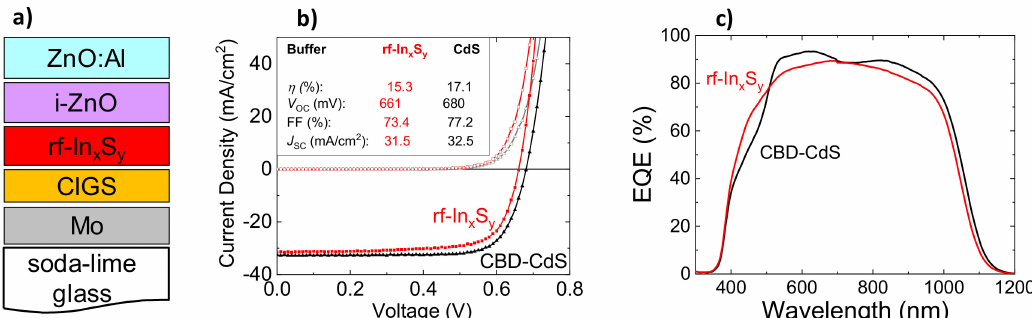
Figure 1. ( a ) Scheme of Cu(In,Ga)Se 2 (CIGS) thin-film solar cell with rf-sputtered In x S y bu ff er layer (not to scale); ( b ) I – V curves of CIGS solar cells either with rf-mangetron sputtered In x S y bu ff er at 220 ◦ C substrate temperature (red) or with a CdS bu ff er layer(black) grown by chemical bath deposition (CBD), both with i-ZnO / ZnO:Al on top. Corresponding solar cell parameters are listed in the inset. J SC values are corrected with EQE; ( c ) External quantum e ffi ciency (EQE) curves of the same